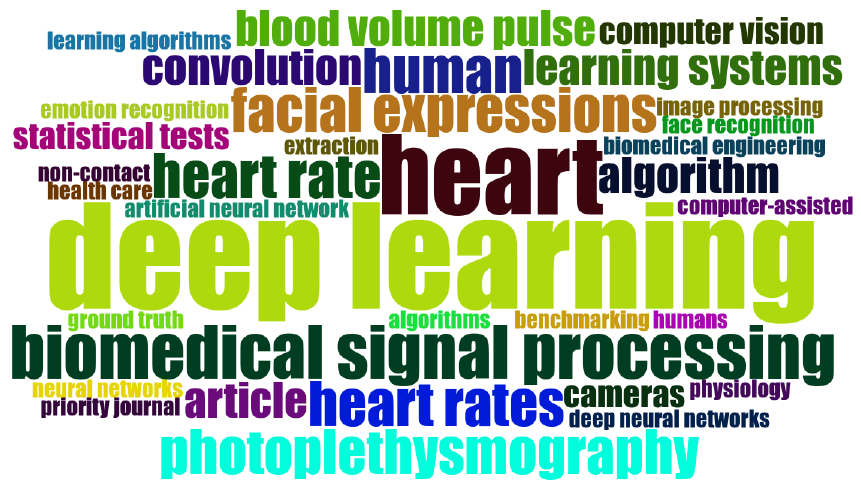
Figure 3. Keyword search cloud.